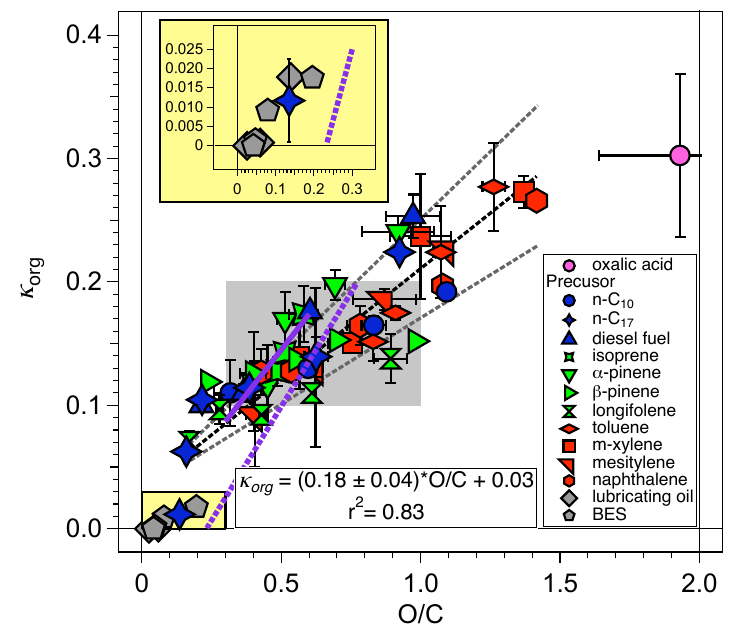
Fig. 7. CCN-derived hygroscopicity parameter ( κ org ) shown as a function of O/C ratio for PAM-generated SOA and OPOA. Symbols are colored by precursor class (blue: gas-phase alkanes, green: biogenic terpenoids, red: aromatics, grey: POA), and error bars represent ± 1 σ in measurements. Figure inset shows low κ org measurements of OPOA and n -C 17 SOA on an expanded scale. Measured κ org of oxalic acid is shown for reference. Solid black line indicates a linear fit to the data (slope=0.18, intercept=0.03, r 2 =0.83) with dashed black lines representing ± 1 σ confidence intervals. Purple dashed and solid lines represent linear parameterizations from Jimenez et al. (2009) and Chang et al. (2010). Shaded rectangle represents typical range of ambient κ org and O/C values (Liu and Wang, 2010; Ng et al.,